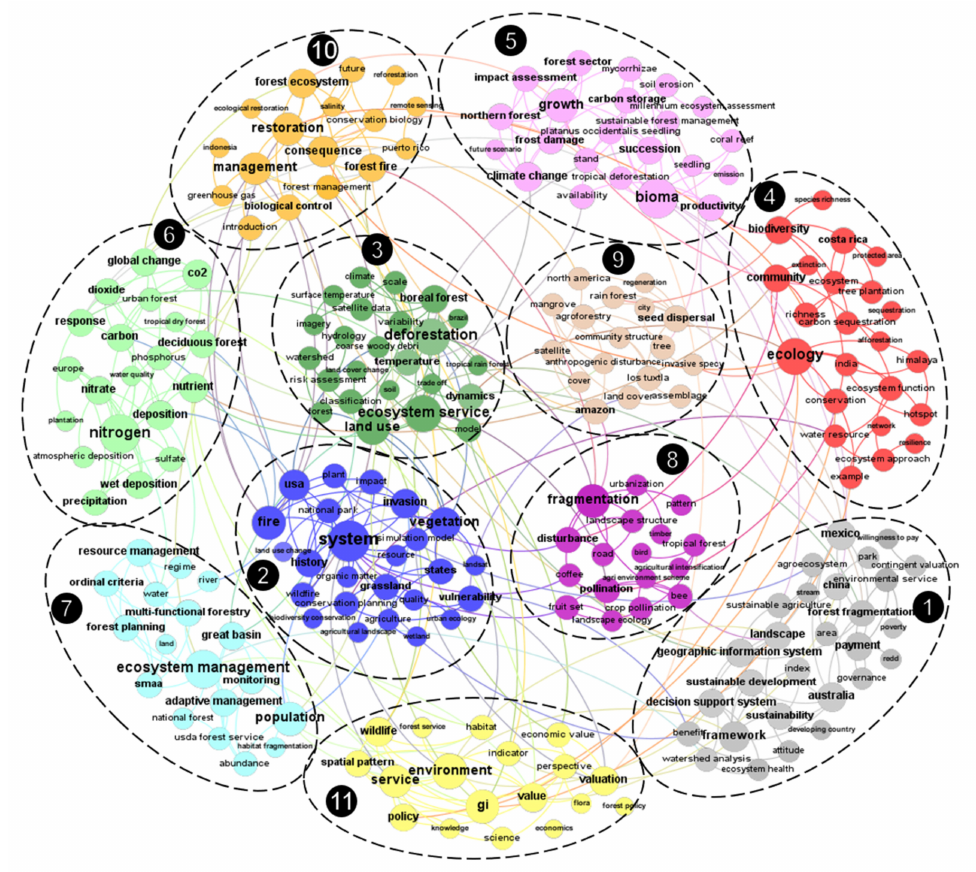
Figure 3. General diagram of keyword clustering of published articles on FES-related topics from 1997 to 2019. Note: ① payments for ecosystem services; ② biodiversity conservation; ③ forest governance; ④ ecosystem approach; ⑤ climate change; ⑥ nitrogen; ⑦ ecosystem management; ⑧ pollination; ⑨ city; ⑩ ecological restoration; ⑪ policy.